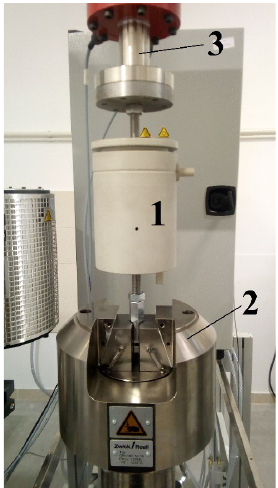
Figure 3. View of the electrochemical charging cell mounted in the mechanical testing machine: (1) cell; (2) moving jaw; (3) load cell connected to stationary beam.